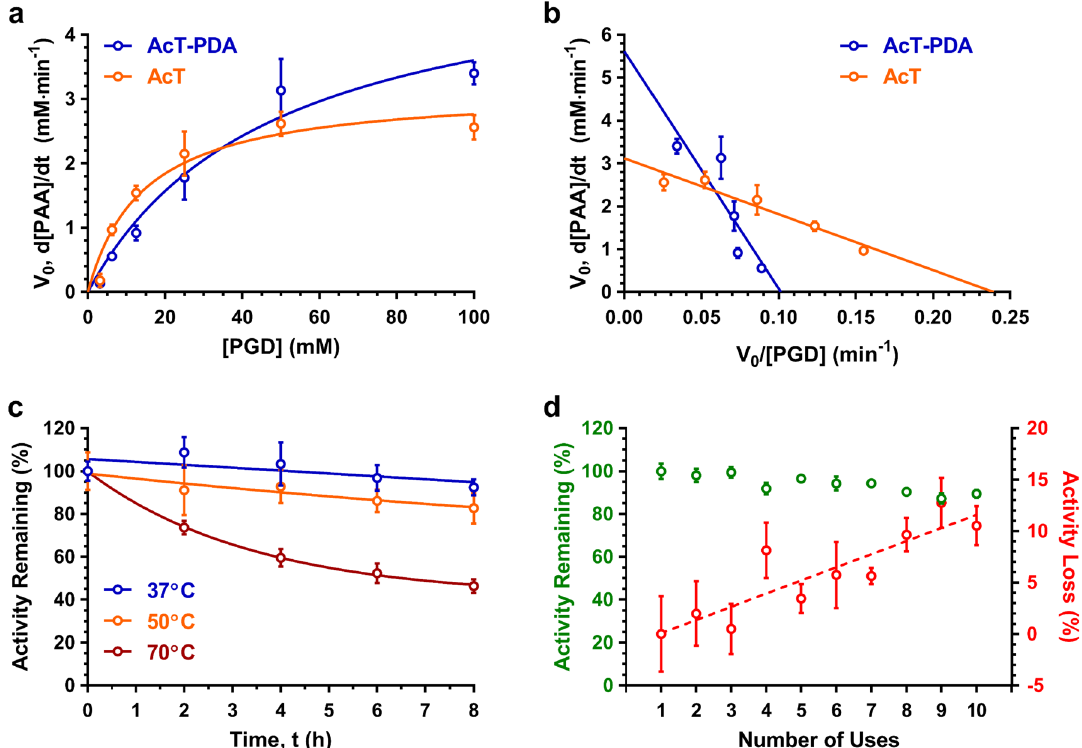
Figure 3. Reaction kinetics, thermal stability, and reusability of AcT-PDA composites. AcT-PDA composites (blue) loaded using an initial AcT concentrations, [AcT] i , of 20 μg AcT mg −1 PDA were compared to free AcT (at corresponding 20 μg AcT mL −1 reaction, orange) for AcT activity. Curves for reaction kinetics were fitted based on ( a ) the Michaelis–Menten equation and ( b ) an Eadie-Hofstee plot fit. ( c ) Residual activity of AcT- PDA composites ([AcT] i = 50 μg AcT mg −1 PDA) after incubating at 37, 50, and 70 °C for up to 8 h. ( d ) Residual activity (green) of AcT-PDA composites ([AcT] i = 50 μg AcT mg −1 PDA) as a function of number of uses at 25 °C. Activity loss (red) shown on expanded right axis to gradual decay in activity. All tests of coating activity were performed with n = 3 replicates. All data shown as mean ± standard deviation; error bars not plotted for some points that have very small standard